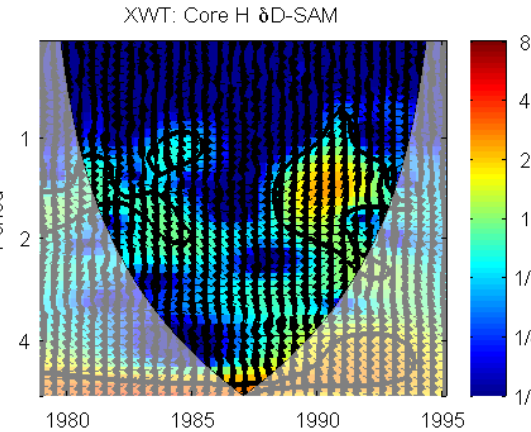
Figure A6. Top panel: core H δ D and core H net accumulation XWT from 1657 to 1995. Middle panel: core H δ D and Niño 3.4 XWT from 1950 to 1995. Bottom panel: core H δ D and SAM XWT from 1979 to 1995.